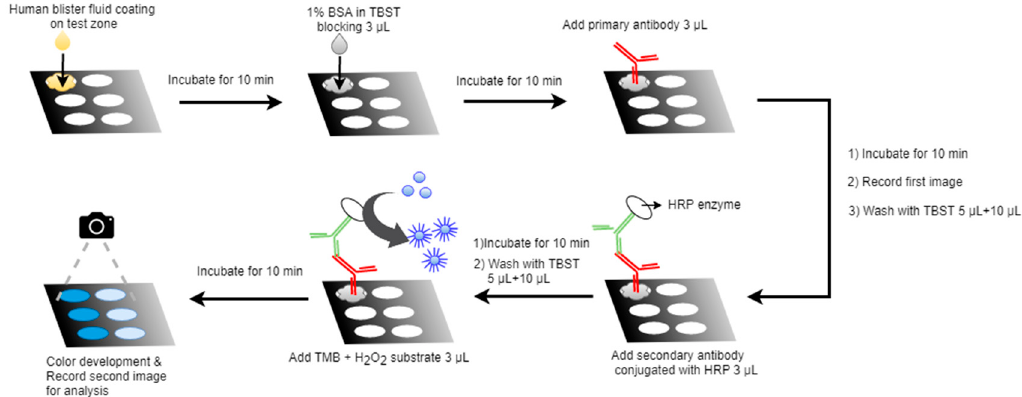
Figure 1. Procedure of paper-based ELISA (P-ELISA) for angiogenin analysis in burn blister fluid. Three microliters of burn fluid was loaded onto the test zone, and the test paper was incubated for 10 min. Three microliters of 1% BSA was then added for blocking, and the test paper was incubated for 10 min. The first image was recorded after loading 3 μ L primary antibody, and the test paper was incubated for 10 min. The test paper was washed with 5 μ L and then 10 μ L TBST (Tris-buffered saline + 0.05% Tween 20) before adding 3 μ L of horseradish peroxidase (HRP)-conjugated secondary antibody. The final procedure was to wash again with TBST and add 3 μ L of substrate solution. After 10 minutes of incubation, we recorded the second image.